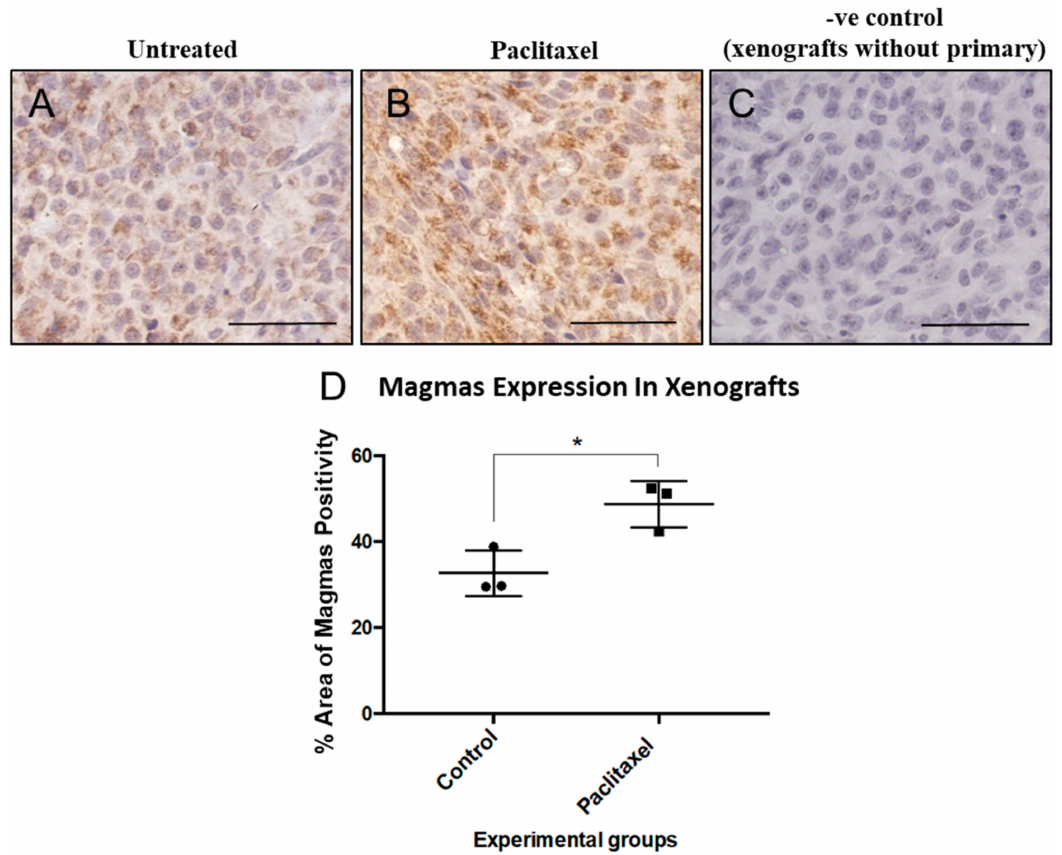
Figure 4. Magmas expression was induced in xenografts treated with chemotherapy.